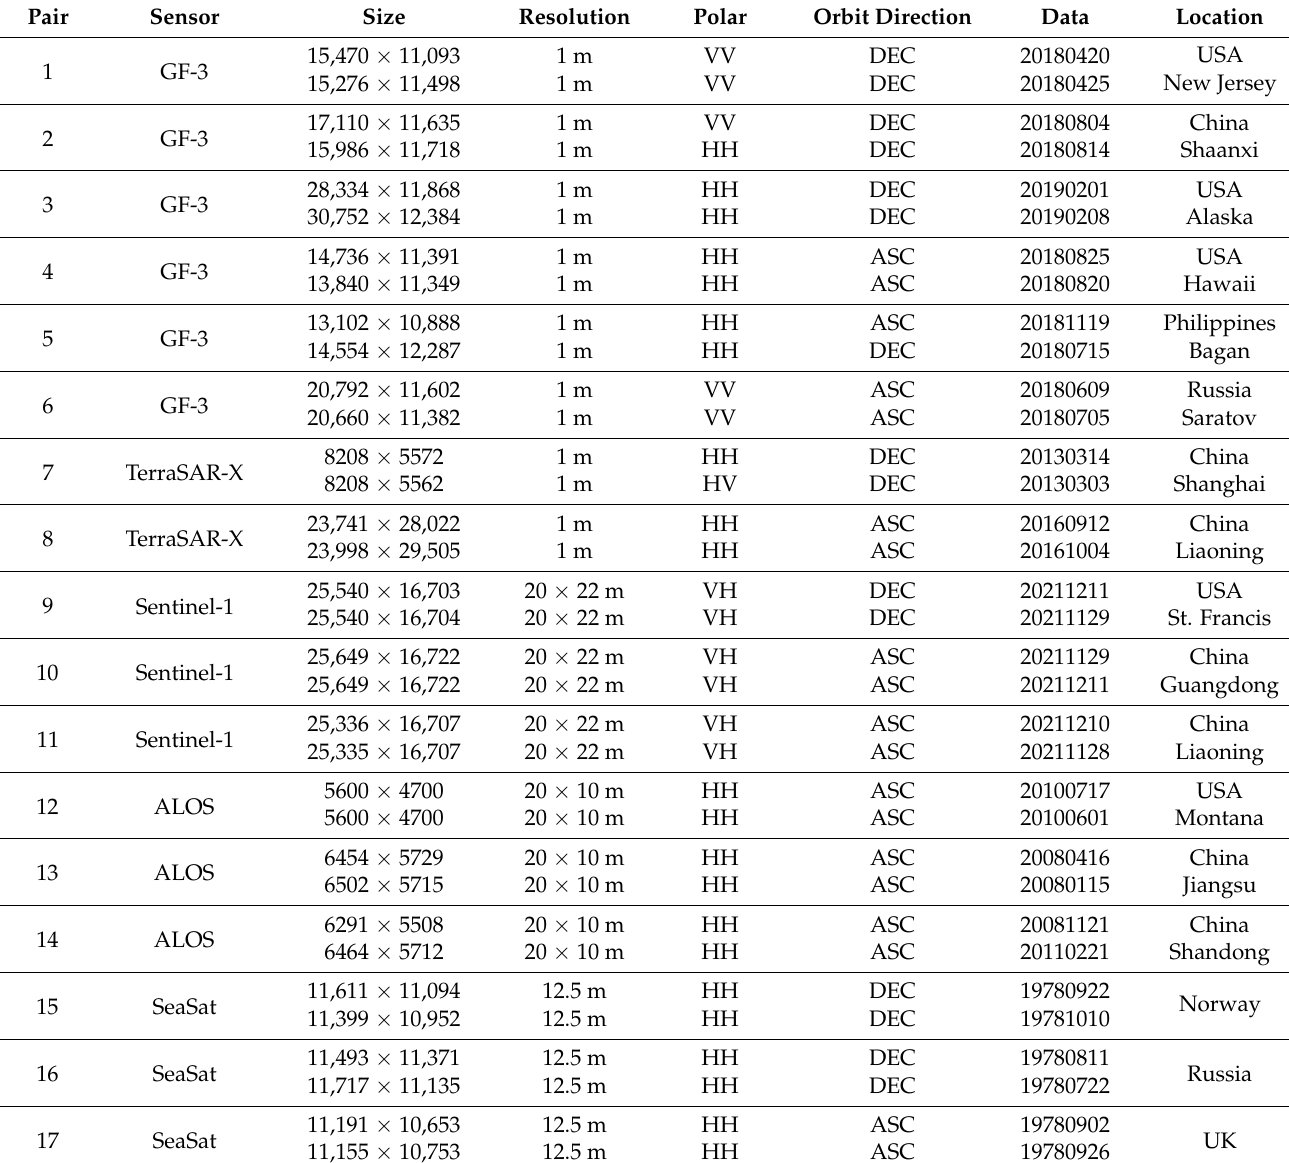
Table 1. Experimental